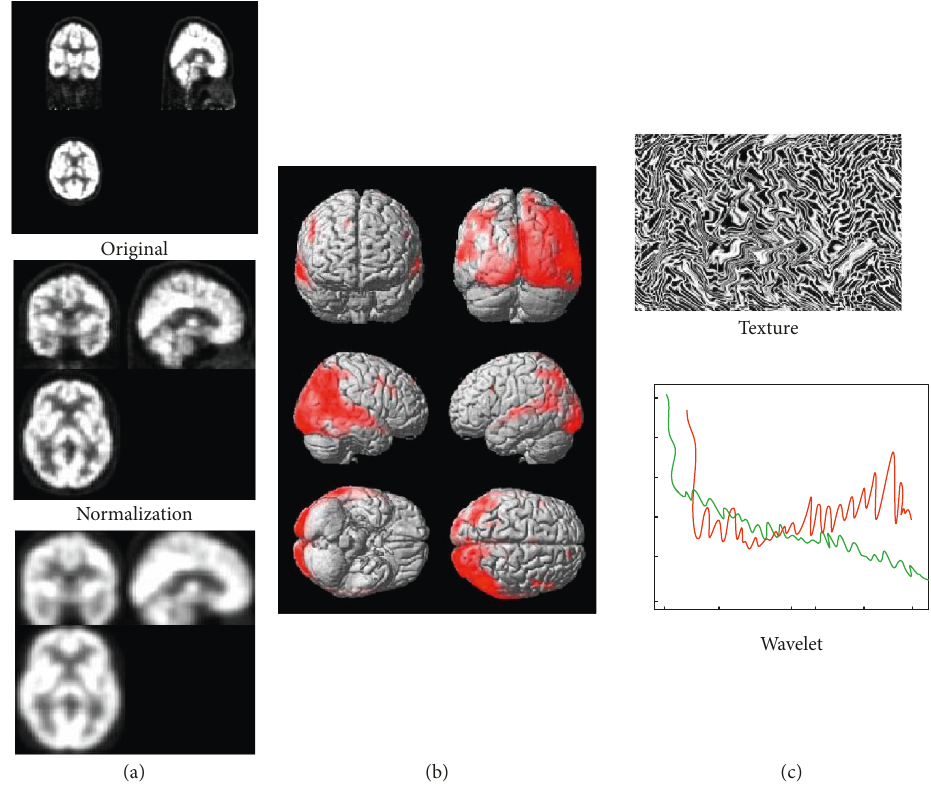
Figure 6: Research process. (a) Preprocessing. (b) Region of interest. (c) Feature